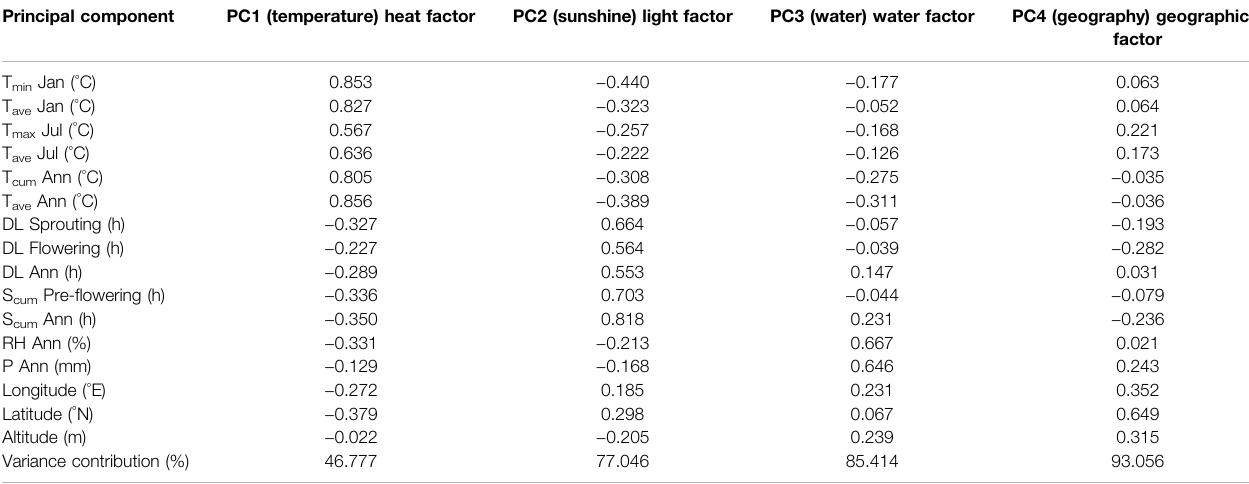
TABLE 2 | Principal component analysis of environmental factors in different cultivated locations. Principal